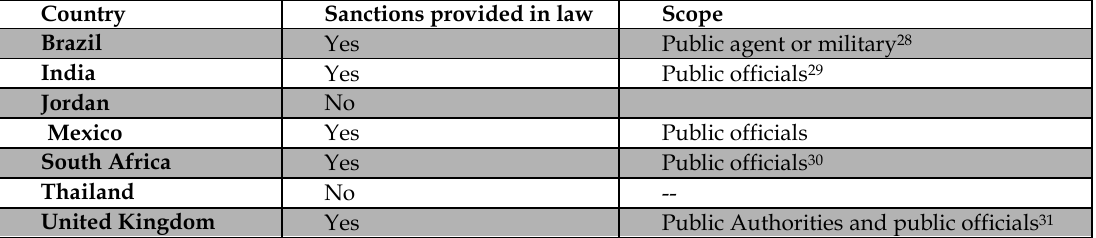
Table 4: Sanctions Provided in Law